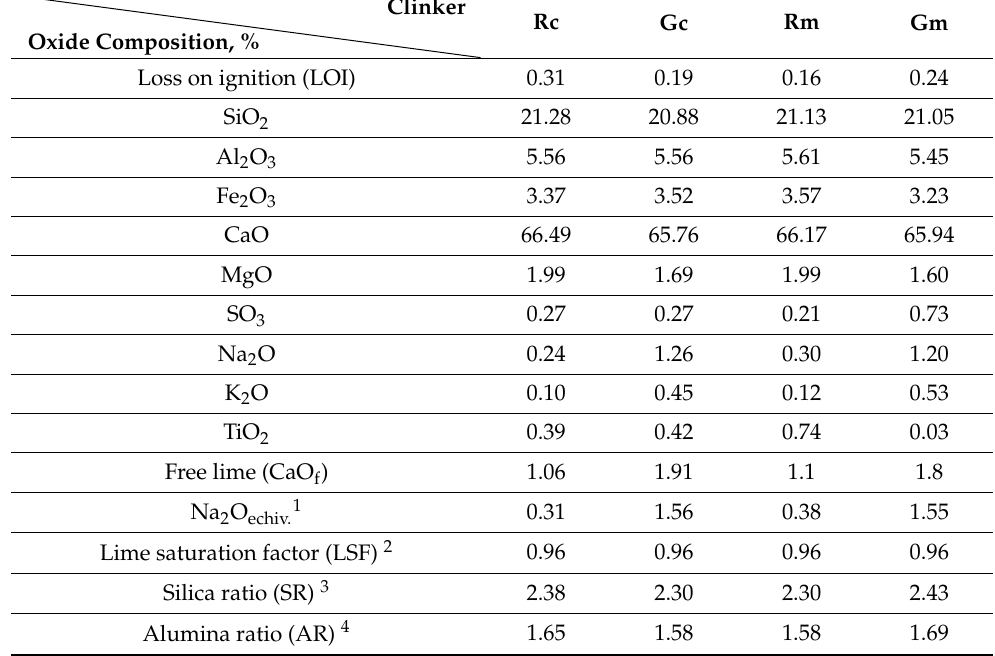
Table 2. Oxide compositions of clinkers.